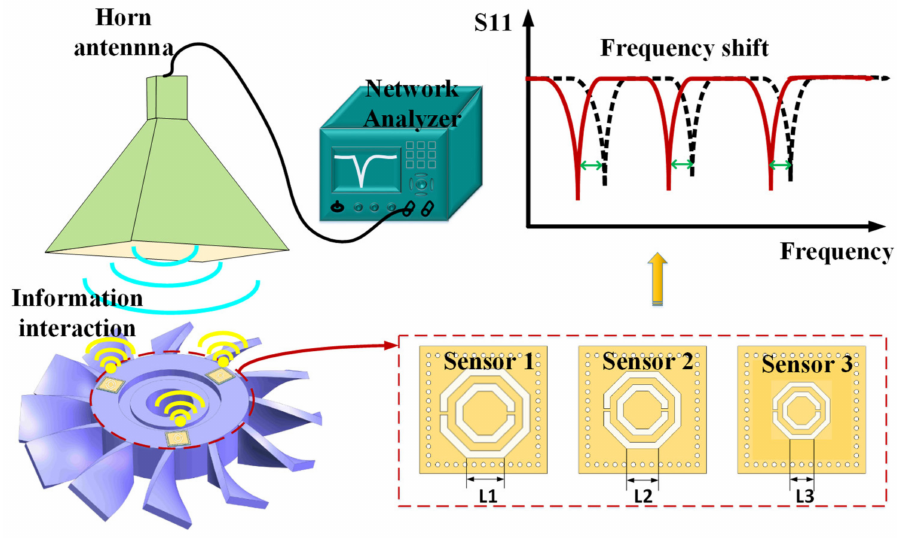
Figure 7. The schematic diagram of the multi-site and netted implementation.